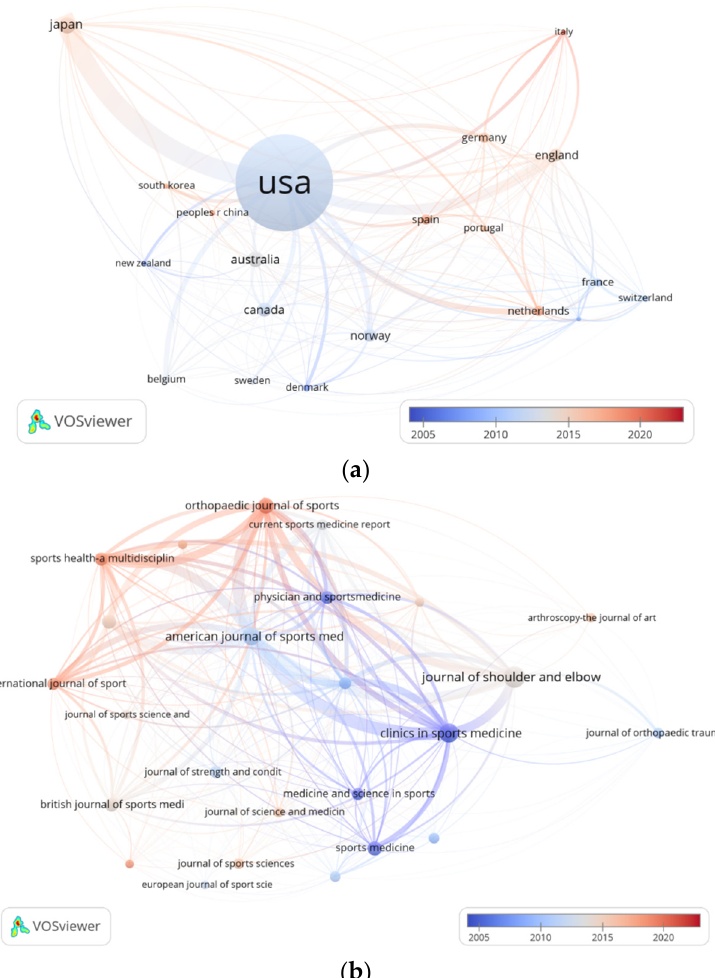
Figure 5. ( a ) Bibliographic coupling of countries. The red color represents the recent trend of country attention to elbow pain. The blue color means that country attention to elbow pain was paid previously. The dimension of the curve indicates the total link strength between countries. ( b ) Bibliographic coupling of sources. The red color represents the recent trend of journal attention to elbow pain. The blue color indicates that journal attention to elbow pain was paid previously. The dimension of the curve indicates the total link strength between journals.